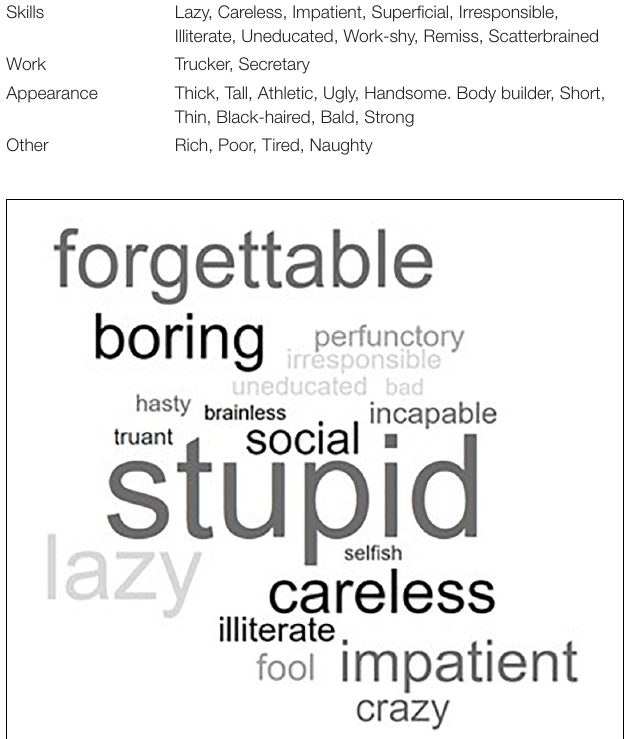
FIGURE 3 | Word Cloud presenting the most frequent words that do NOT describe scientists.